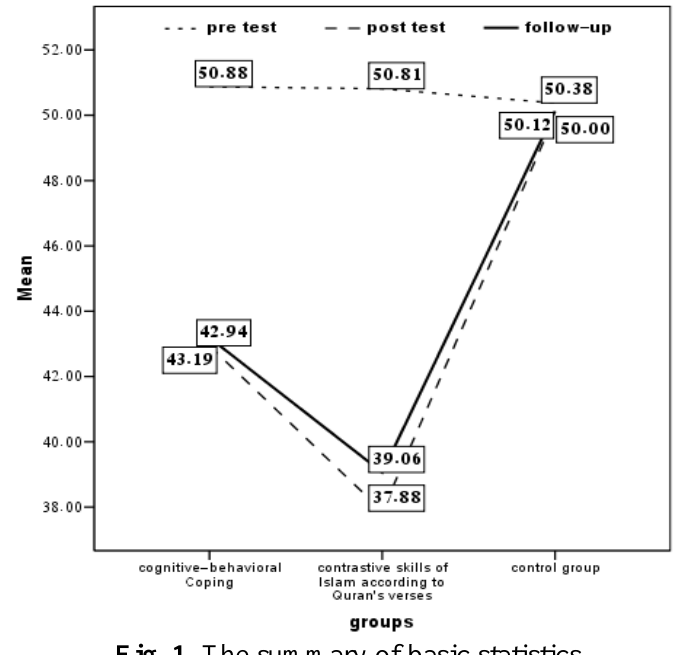
Fig. 1. The summary of basic